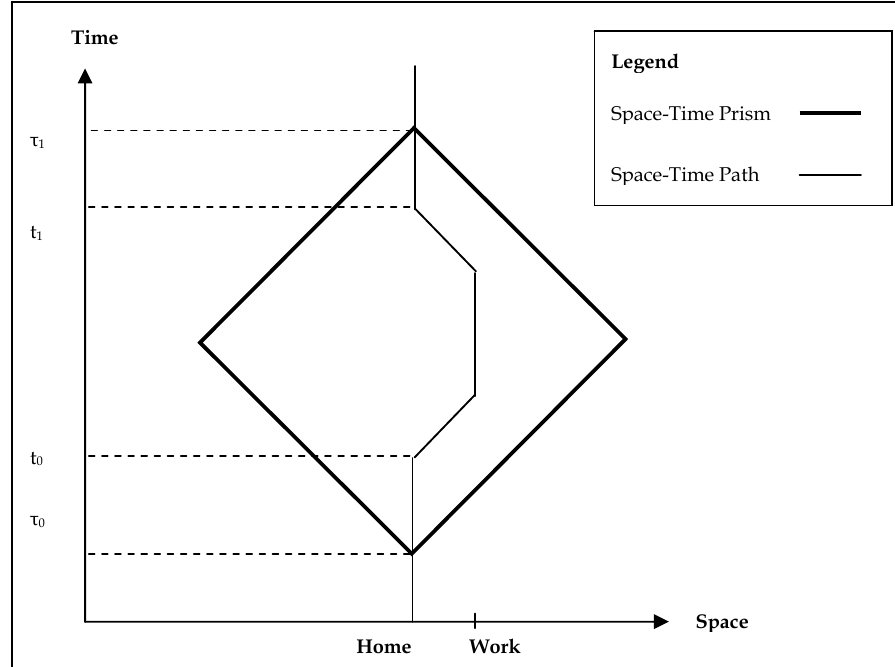
Figure 1. Illustration of the space-time